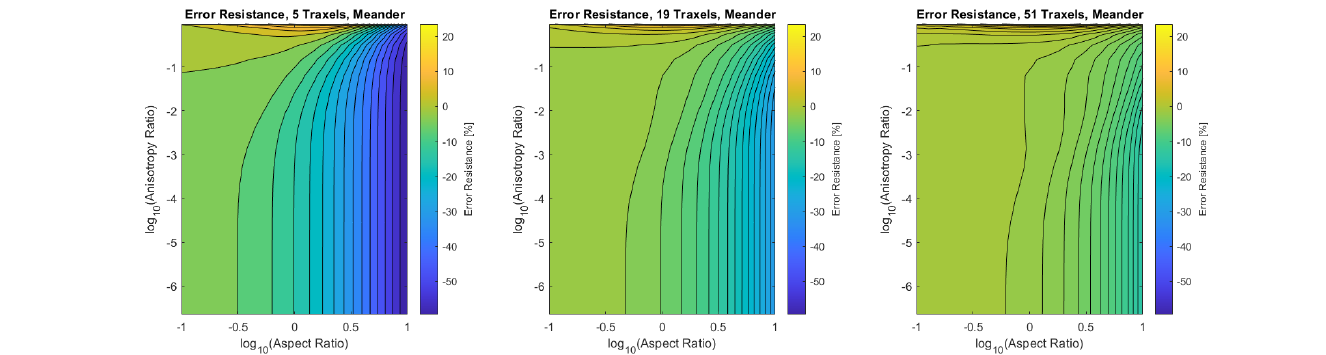
Figure 16. The error of the total resistance for the open-ended case with different numbers of traxels. The RMS-error for the different numbers of traxels is, respectively, 4.75%, 2.51%, and 1.97%.